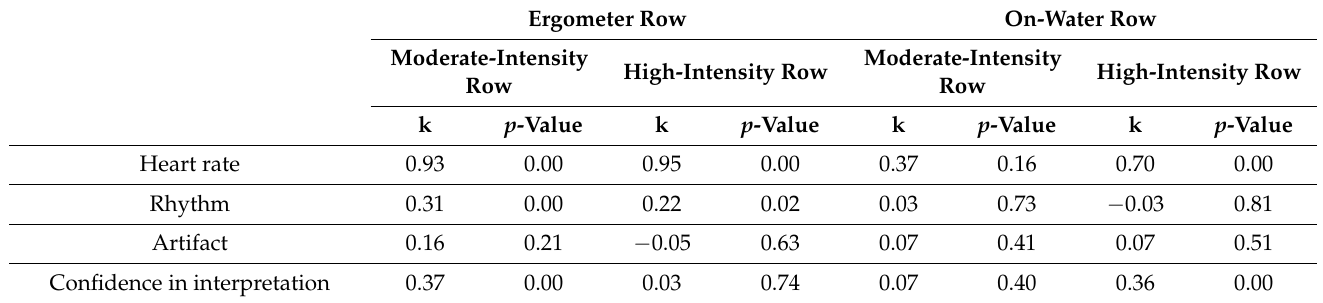
Table 2. Inter-rater reliability between readers. Ergometer Row On-Water Row